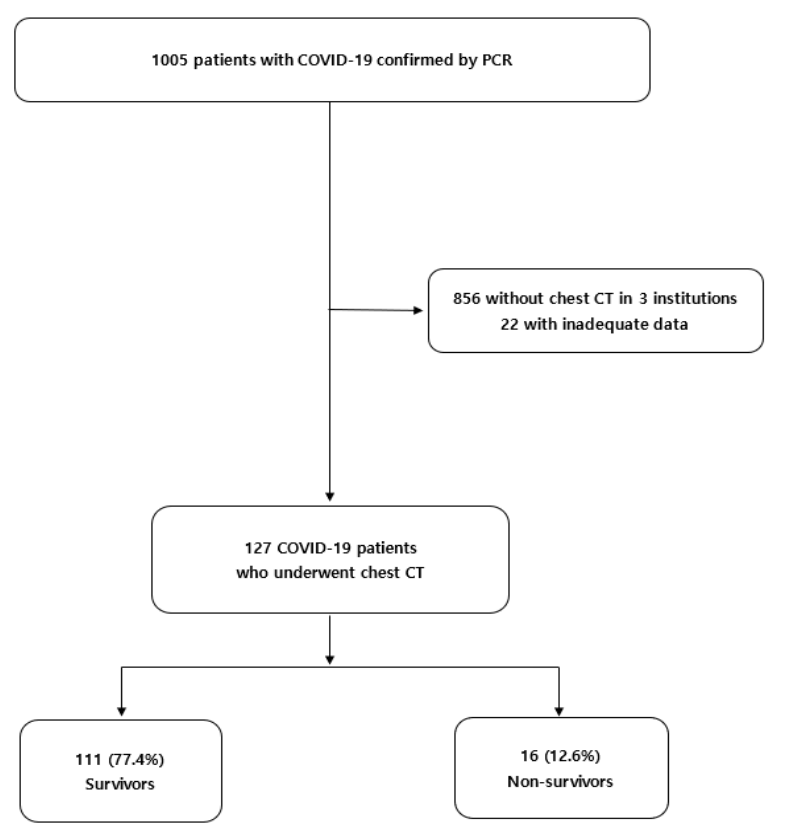
Figure 1. Flow chart of the patients with COVID-19 who underwent chest CT. CT, computed to- mography.